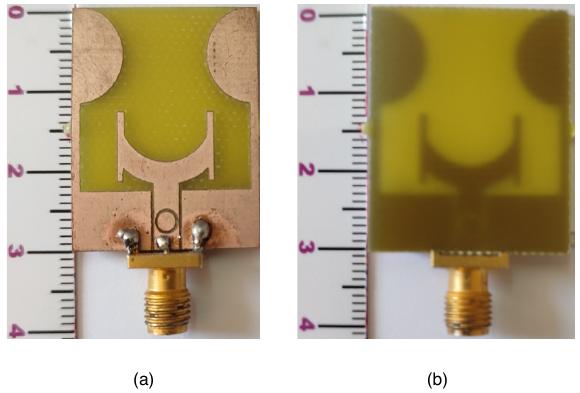
FIGURE 6. Influence of different positions of the split ring over the higher frequencies of the UWB.